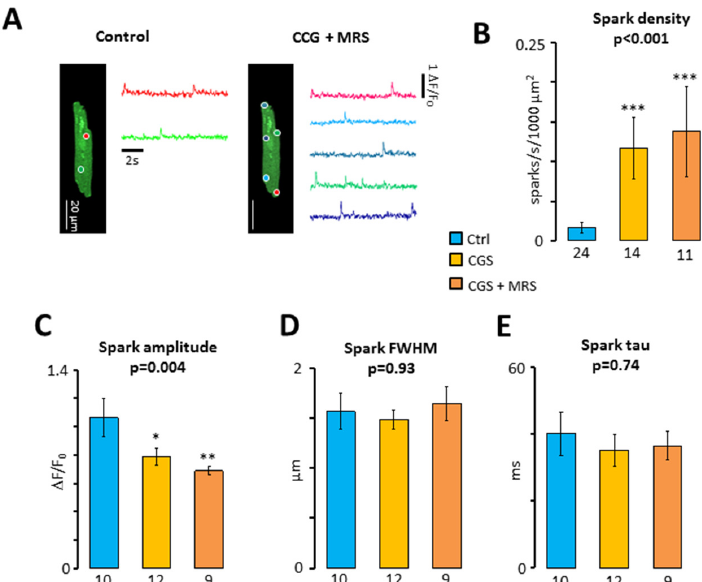
Figure 4. Impact of the crosstalk between A 3 R and A 2A R on calcium sparks. ( A ) Calcium spark recordings (colored traces) from their respective spark sites (colored circles) in a patient before and after exposure to 200 nM CGS21680 + 1 µ M MRS1191; ( B ) spark density (sparks/s/1000 µ m 2 ). Sparks were recorded in 10 patients before (blue) and after perfusion of myocytes with CGS21680 (yellow) and CGS21680 and MRS1191 (orange). Number of cells are given below bars; ( C ) spark amplitude (dF/F 0 ); ( D ) spark full width at half maximum (FWHM, μ m); ( E ) tau for spark decay (ms). Significant differences between the control and treatments are indicated with* p < 0.05; ** p < 0.01; *** p < 0.001. Data were analyzed using Kruskal–Wallis ( p -values are given above Bars) and Dunn’s post-test in ( B ) and ANOVA with Welch’s correction in panel ( C – E ). Number of cells with sparks are given below the bars in panel ( C – E ).